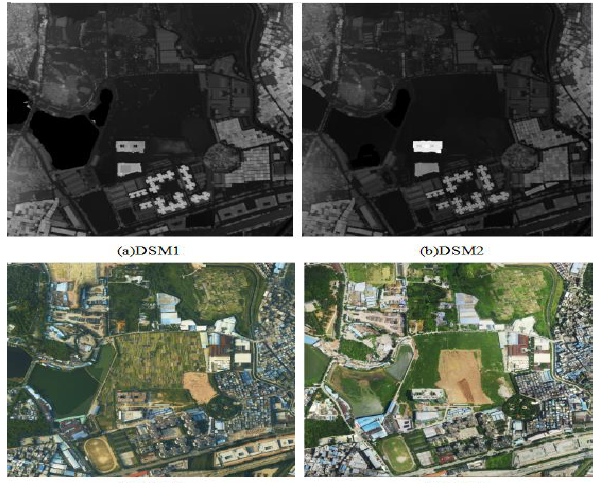
Figure 1. Two periods of DSMs and